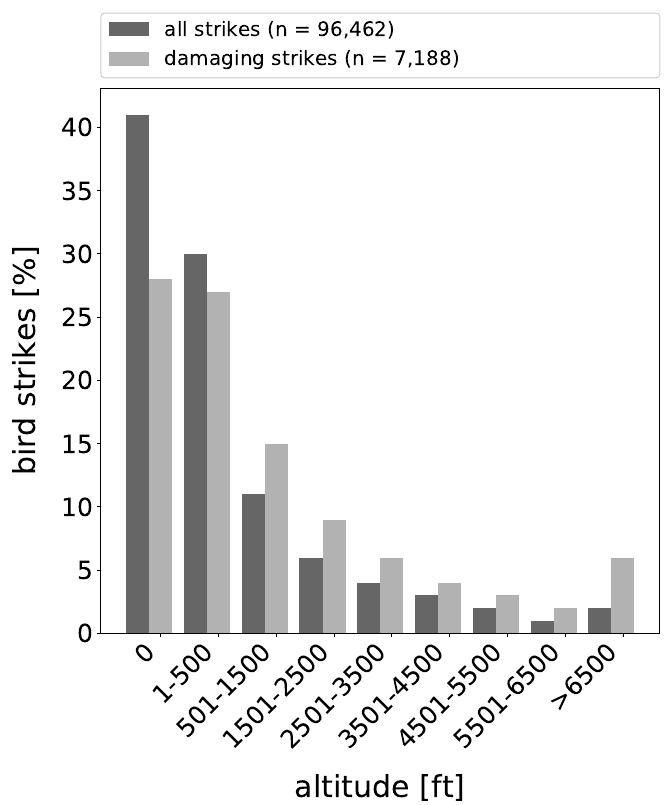
Figure 2. Distribution of bird strikes by altitude band that occurred between 1990 and 2018 in the USA, where the altitude was known (72% for all strikes, 70% for damaging strikes). Source: